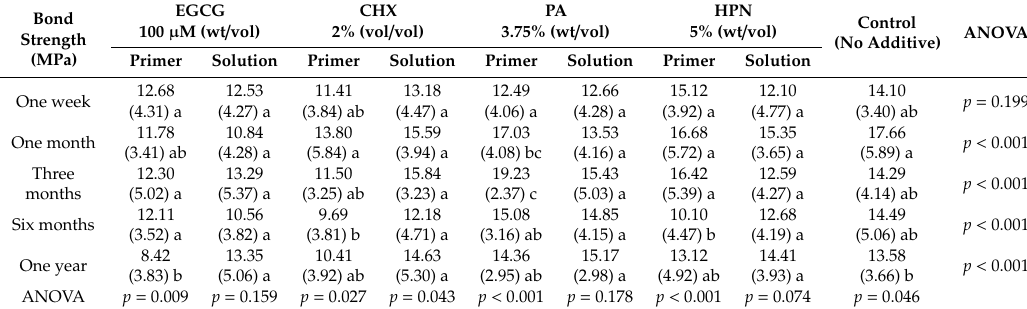
Table 2. Mean and standard deviation of SBS as a function of immersion duration; p -values signify the ANOVA results of each column / row; di ff erent lowercase letters indicate significant di ff erences in a column tested by Tukey’s post-hoc